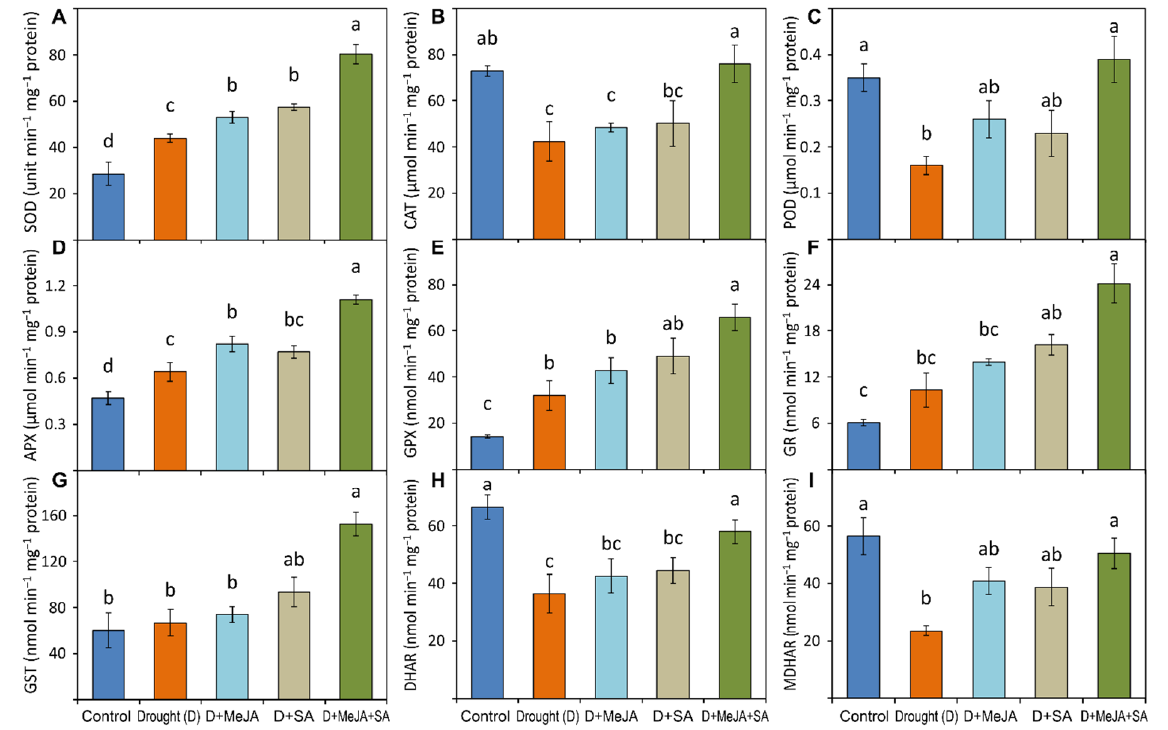
Figure 5. Specific activity of ( A ) superoxide dismutase (SOD); ( B ) catalase (CAT); ( C ) peroxidase (POD); ( D ) ascorbate peroxidase (APX); ( E ) glutathione peroxidase (GPX); ( F ) glutathione reductase (GR); ( G ) glutathione-S-transferase (GST); ( H ) dehydroascorbate reductase (DHAR); ( I ) monodehydroascorbate reductase (MDHAR) of French bean plants grown under control, drought (D), and drought-stressed plants treated with methyl jasmonate (D + MeJA), salicylic acid (D + SA), and their combination (D + MeJA + SA). Vertical bars represent +/− SE values. Different le(cid:308)er(s) denote a significant difference at p ≤ 0.05. Additional details are shown in Figure 1.